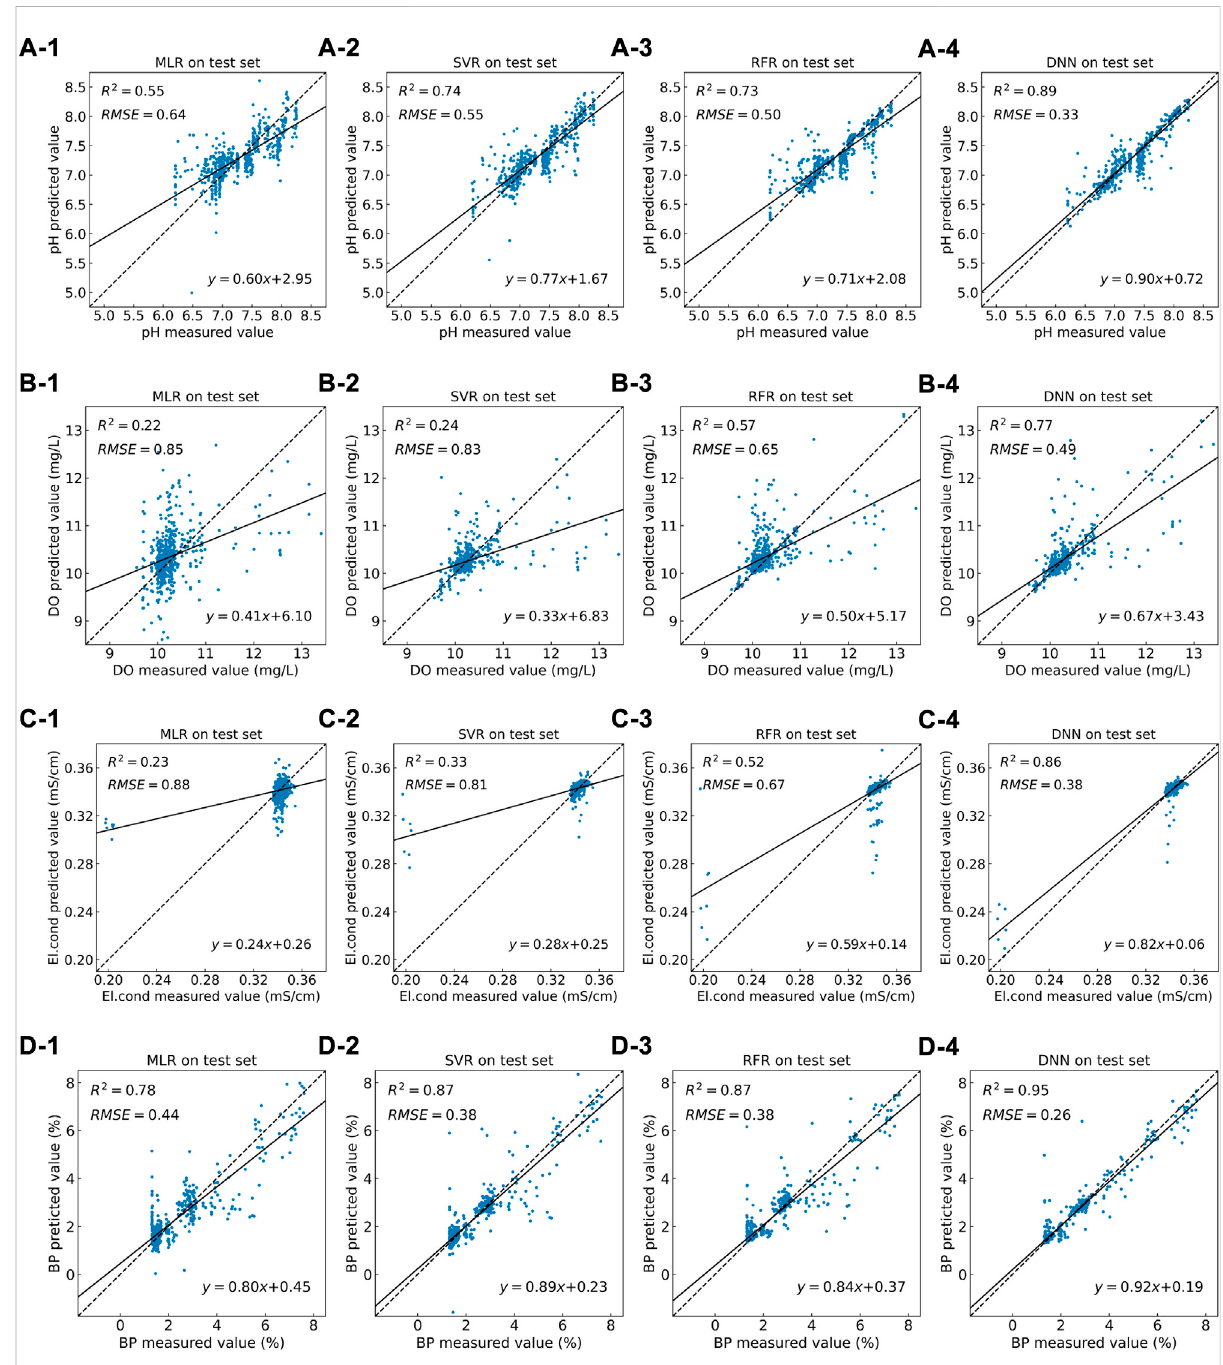
FIGURE 3 Regression model performance evaluation by comparison of the predicted data and measured data on a test set, where (A) , (B) , (C) , and (D) representthetestresultsofthepH,DO,El.cond,andBP,respectivelyand(1),(2),(3),and(4)representthetestresultsoftheMLR,SVR,RFR,andDNN,